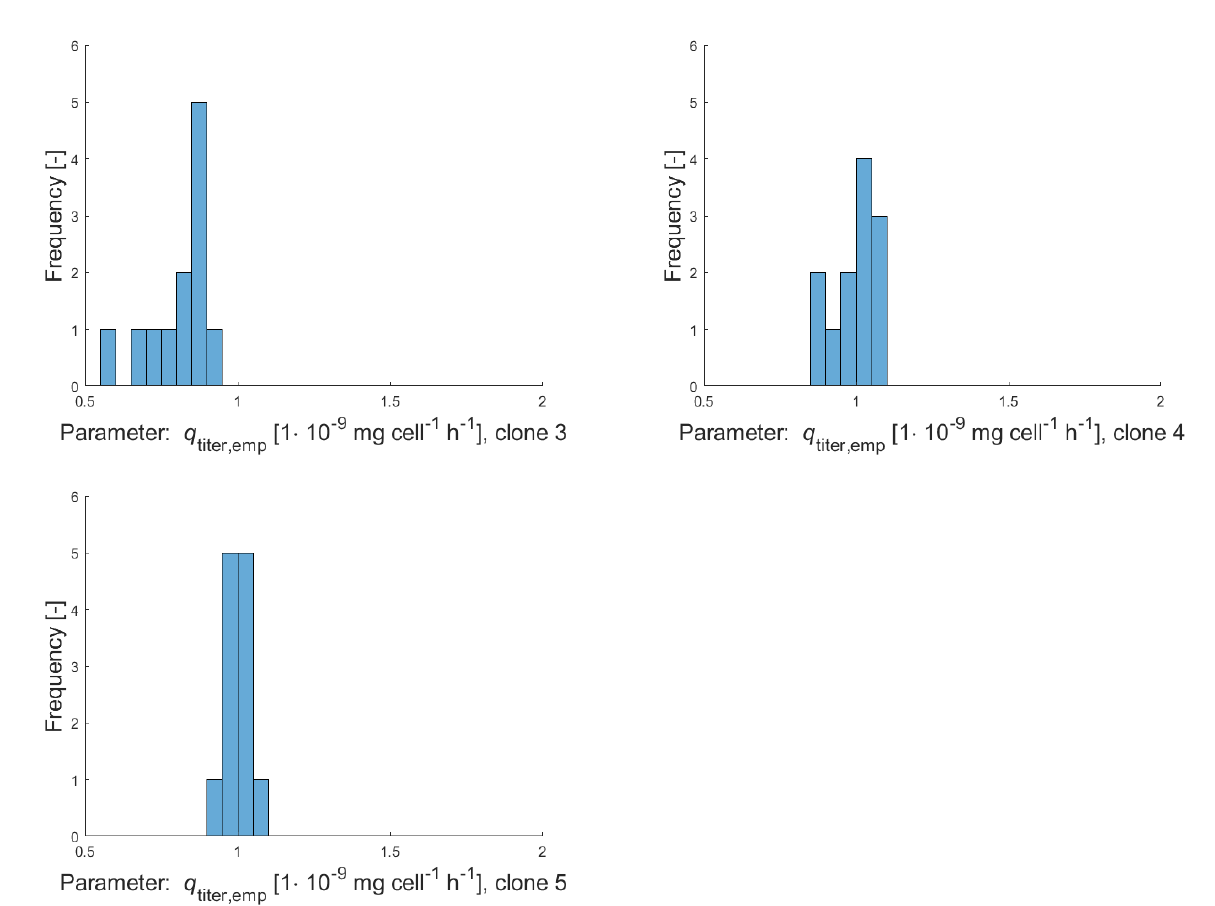
Figure A3. Histograms of empirical production rates for clonal populations clone 1–clone 5 calculated over several subcultivation steps with culture volumes of 5 mL (during a period of 13 weeks).